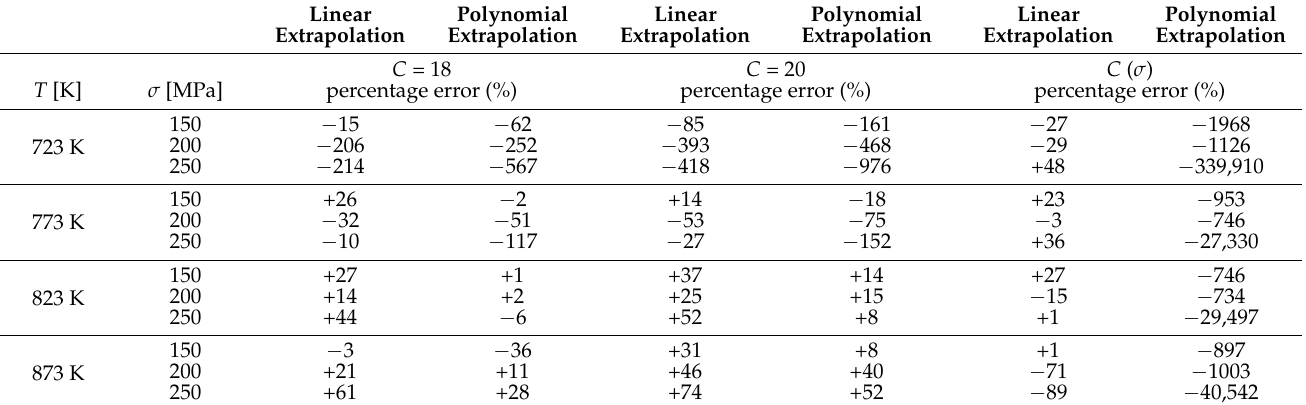
Linear Polynomial Extrapolation Extrapolation